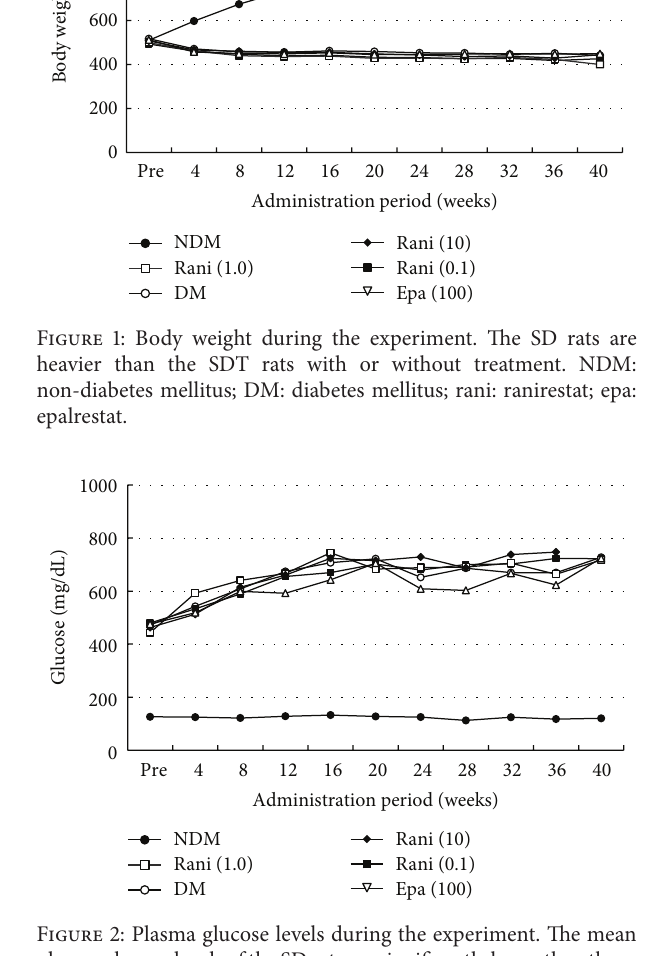
weeks ( 2.6 ± 0.3 for 0.1 mg/kg/day; 0.1 ± 0.1 , for 1 mg/kg/day; 0.0 ±